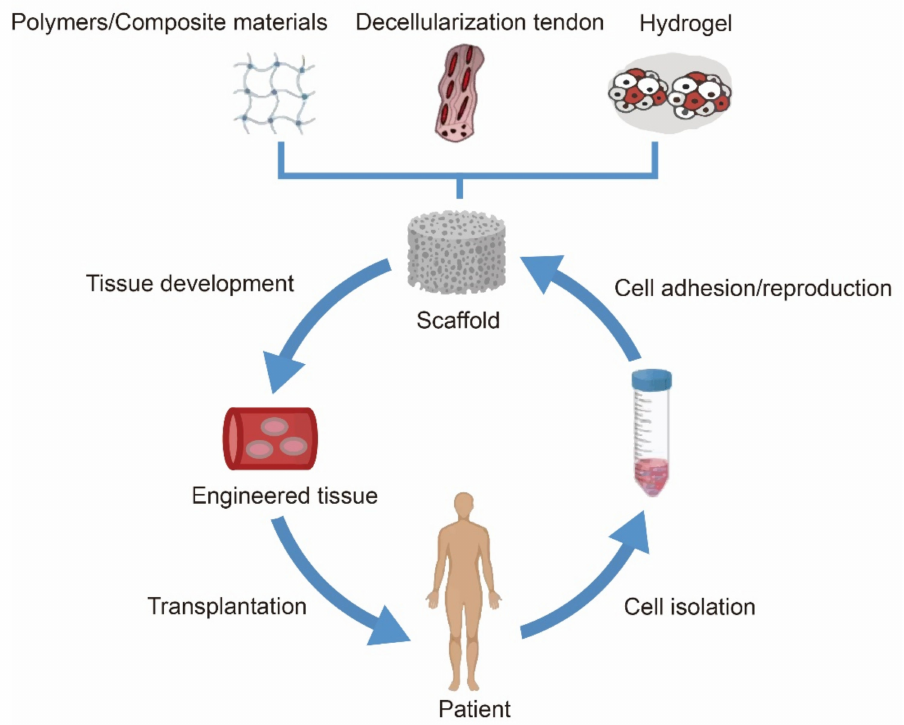
Figure 4. Scaffold preparation for tissue